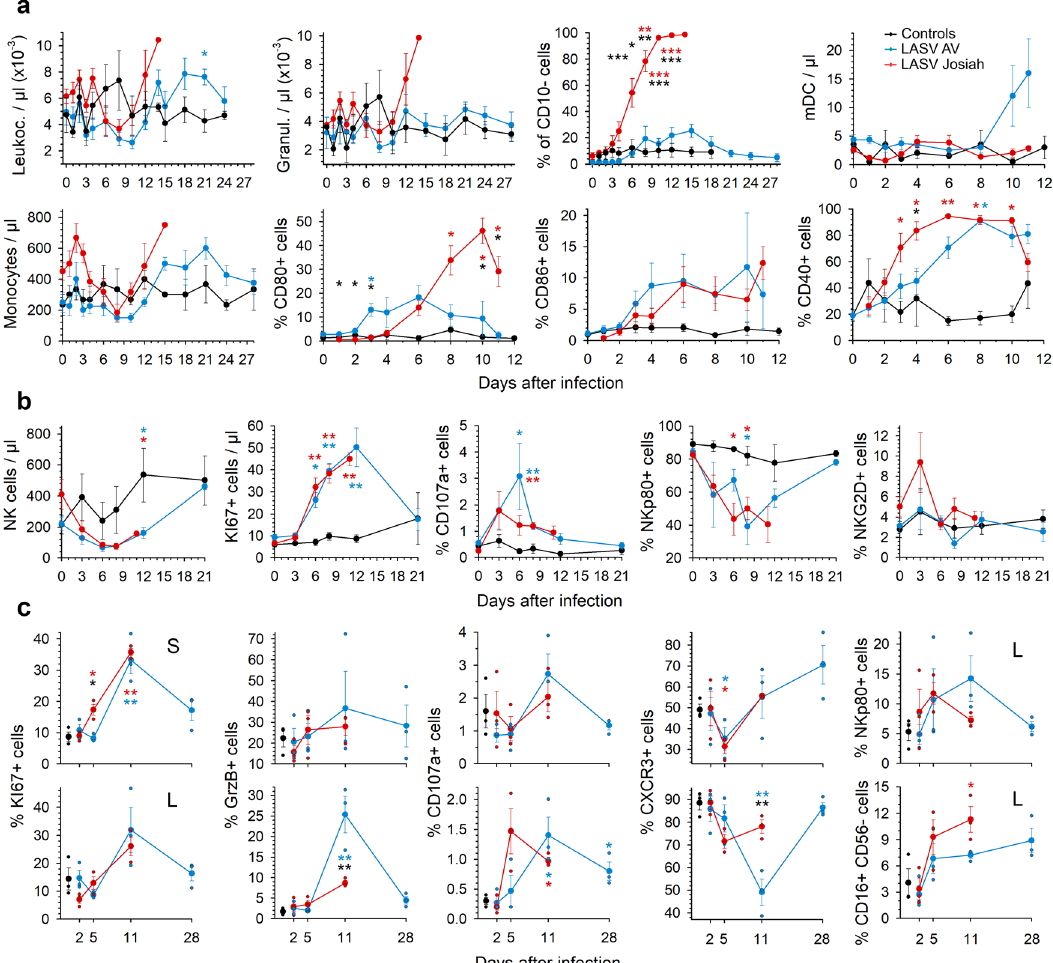
Fig. 4 Analysis of circulating innate immune cells after LASV challenge. a The number of leukocytes, granulocytes, mDC (HLA-DR + CD14 − CD1c + and HLA-DR + CD14 − CD11c + ), and monocytes (HLA-DR + CD14 + ) in the blood is presented according to the time after LASV infection. The percentage of CD10 − cells among granulocytes is also presented. The percentage of monocytes expressing CD80, CD86, or CD40 is shown. Results show the mean ± standard error of the mean (SEM) for each group: controls ( n = 3), LASV-Josiah ( n = 6, except for day 14 where n = 2) and AV-infected animals ( n = 4) were analyzed for leukocyte, granulocyte, CD10 − , and monocyte numbers. For mDC, CD80, CD86, and CD40 analysis, six AV-infected animals were analyzed from day 0 to 6 and three of them from day 8 to 11. b The number of circulating NK cells (CD8 + CD3 − CD20 − cells) is presented, as well as the percentage of KI67 + , CD107a + , NKp80 + , and NKG2D + cells among NK cells ( n = 3 for controls, n = 6 for LASV-Josiah, and n = 4 for AV-infected animals). Statistical analyses were performed and are presented as in Fig. 1. Individual values can be found in Supplementary data 1 for a and b. c The proportion of NK cells (CD8 + CD3 − CD20 − ) expressing KI67, (granzyme B) GrzB, CD107a, CXCR3, and NKp80 was quanti fi ed in spleen (S, upper graphs) and MLN (L, lower graphs) of controls ( n = 3), AV- ( n = 3), and Josiah-infected ( n = 3) animals, as well as the percentage of CD16 + CD56 − cells among NK cells. Individual values and mean ± SEM are expressed for each group. Statistical analyses were performed and are presented as in Fig.